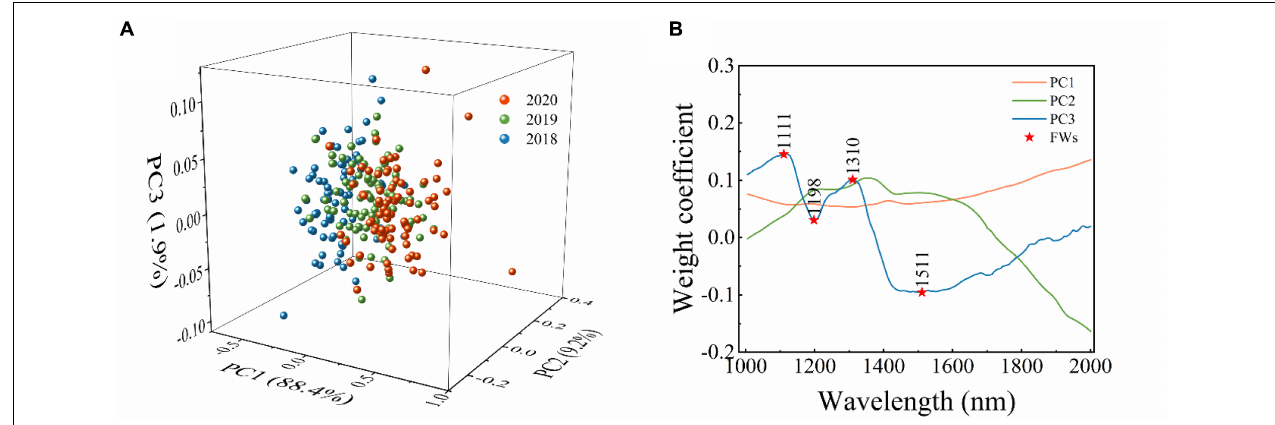
FIGURE 2 | The results of PCA analysis of embryo-side original reflectance spectra. (A) Scatter plot of first three principal components, and (B) loading plots for the first three principal components. Abbreviations: PC1: the first principal component. PC2: the second principal component. PC3: the third principal component. FWs: the feature